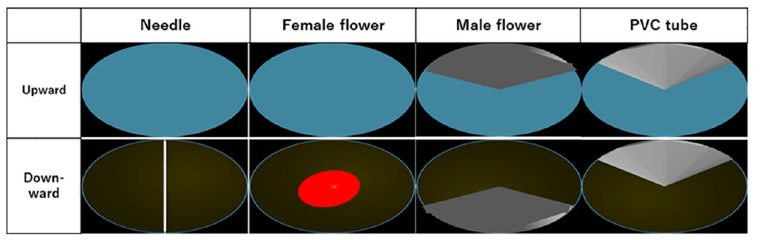
Fig 9. Views from WCSBs on needles, female cones, male cones, and PVC